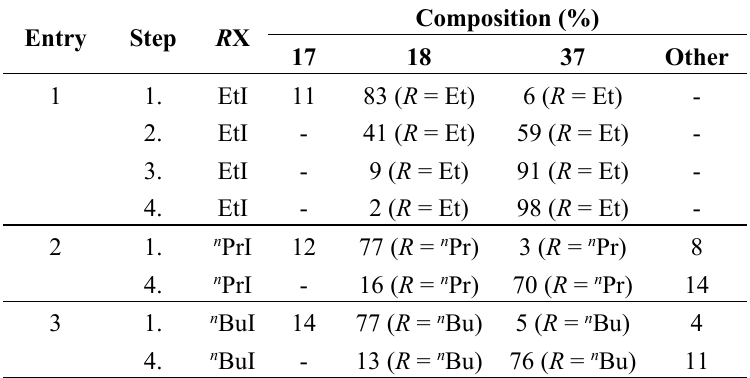
Table 10. MW-assisted dialkylation of ethoxycarbonylmethylphosphonate ( 17 ) by a four-step alkylating protocol.